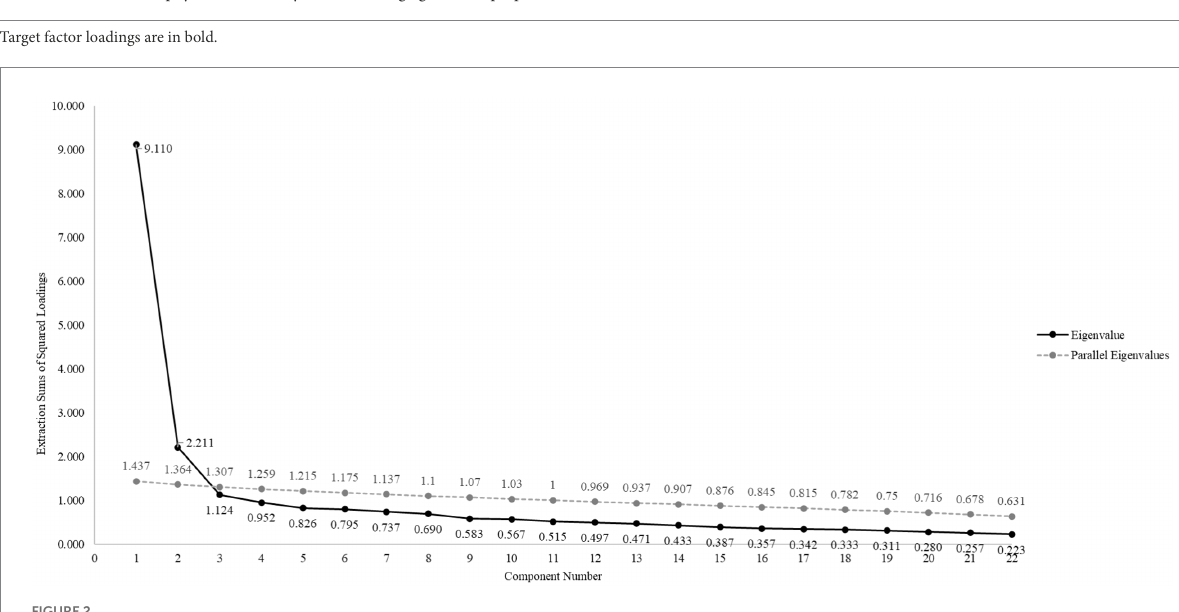
FIGURE 2 Scree plot with original and parallel analysis